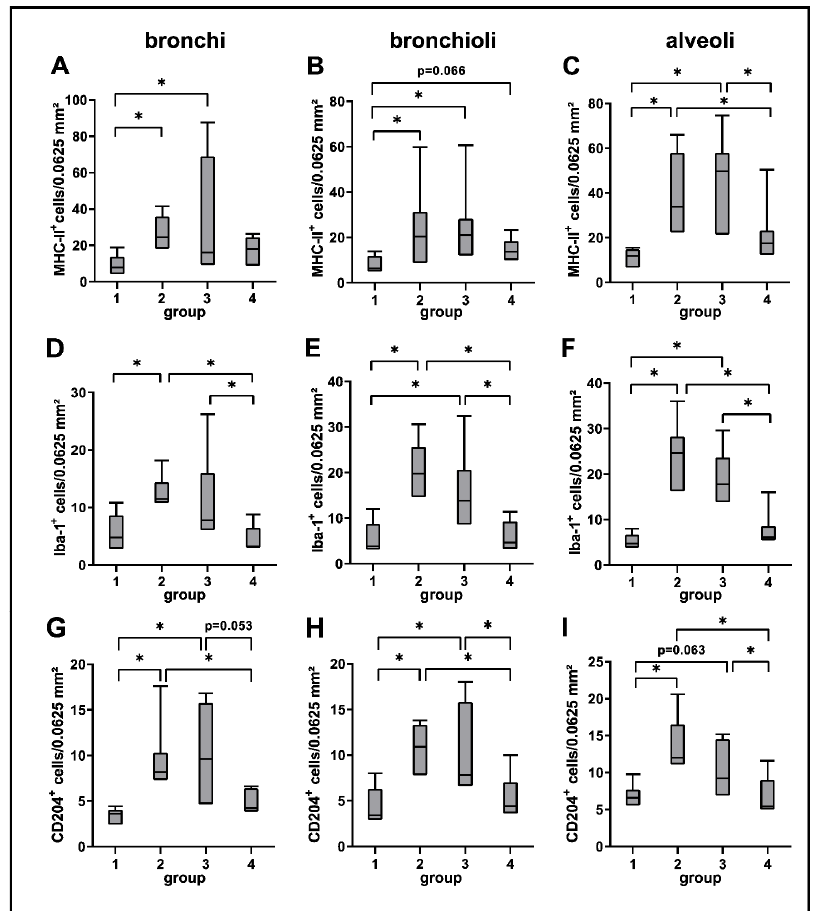
fection. Scale bars: 50 μ m.